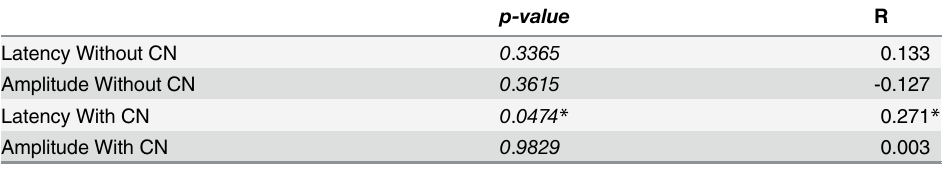
Table 4. Pearson's Correlation Coefficient between age and P300 measures [latency (ms) and ampli- tude ( μ V)]. p-value R Latency Without CN 0 . 3365 0.133 0 . 3615 -0.127